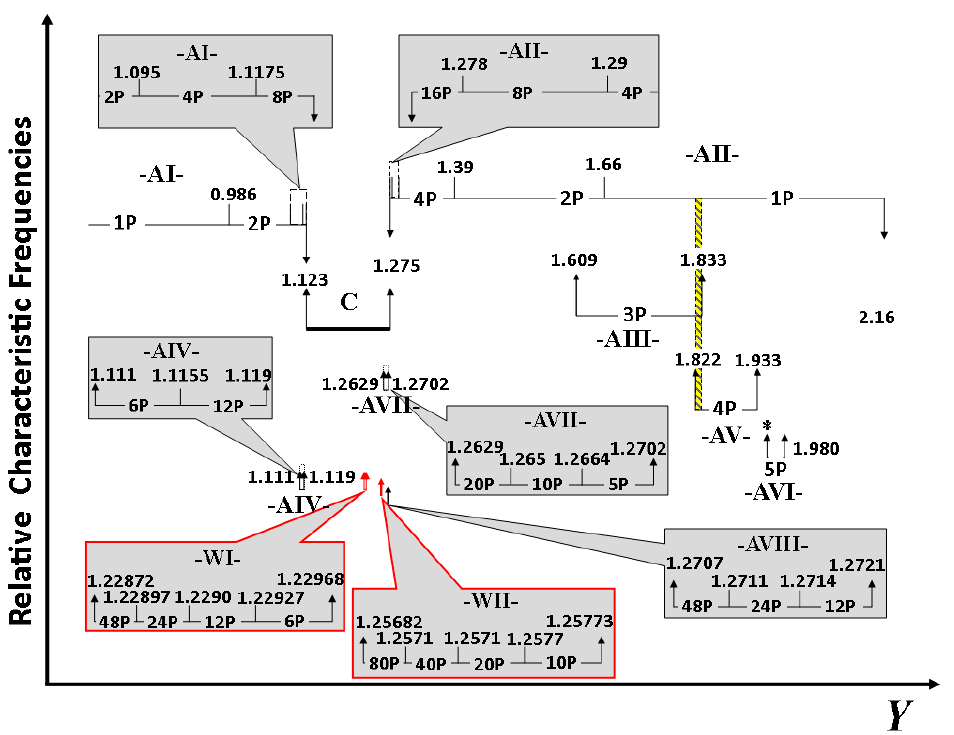
Figure 1. Schematic of the global behavior of LIS is shown for parameters C = 3 , (cid:101) ∆ = 0.5 , (cid:101) κ = 0.1 , (cid:101) γ = 0.01 , (cid:101) κ = − 0.5 . 1P , 2P , etc. denote limit cycles; AI-AVIII are individual attractors and WI and WII are periodic windows in chaos; C is chaos; vertical arrows represent attractor transitions. The hashed rectangle (in yellow) indicates the Y domain where AII, AIII, and AV coexist. The asterisk * indicates the transition from AVI to AII at Y = 1.948 .